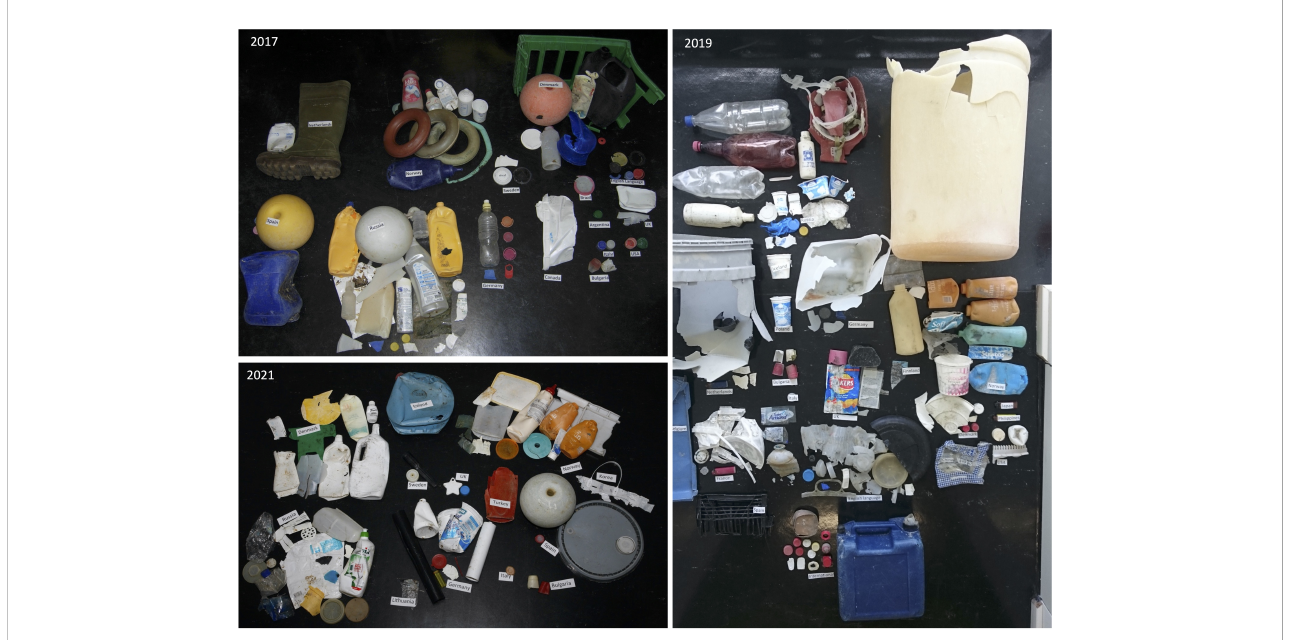
FIGURE 5 Items of determined provenance from 2017, 2019 (© M. Bergmann) and 2022 (© J.